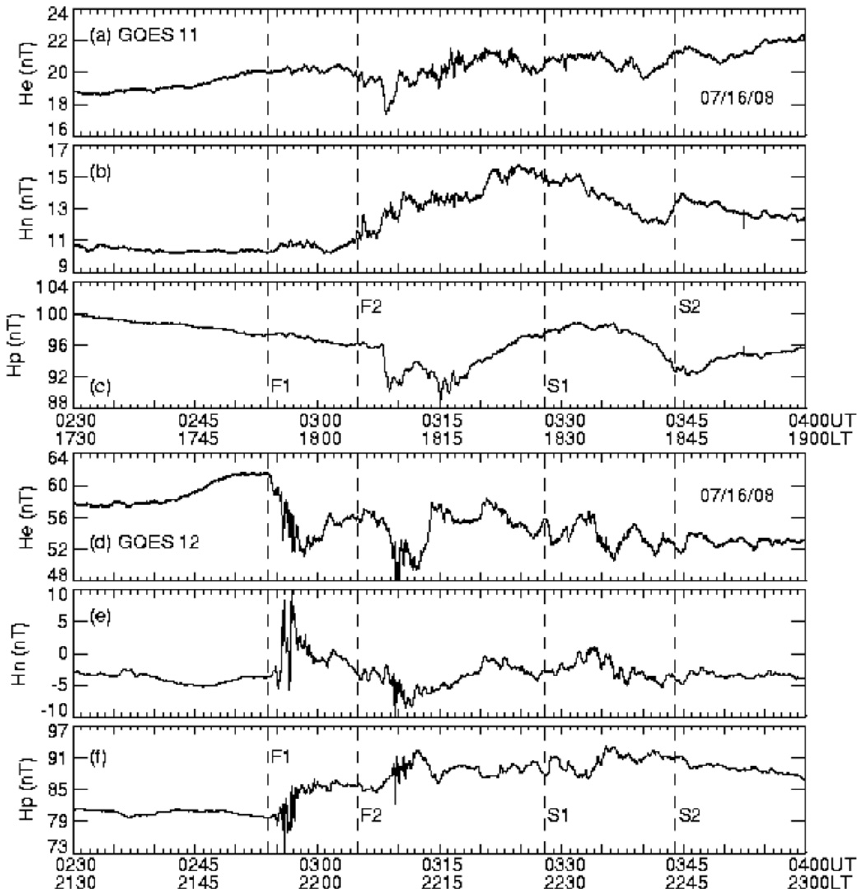
Fig. 9. (a) – (c) The He, Hn and Hp components at GOES 11 from 02:30UT to 04:00UT on 16 July 2008. (d) – (f) In the same format as Fig. 9a, except for GOES 12. The vertical dashed lines denote ground Pi2